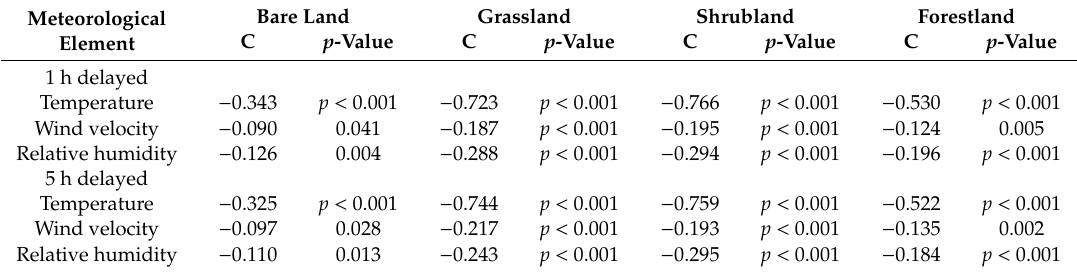
Table 16. Results of the Spearman correlation analysis between soil moisture content and meteorological factors with 1 h and 5 h for hysteresis respectively in a continuous period without rainfall in the dry